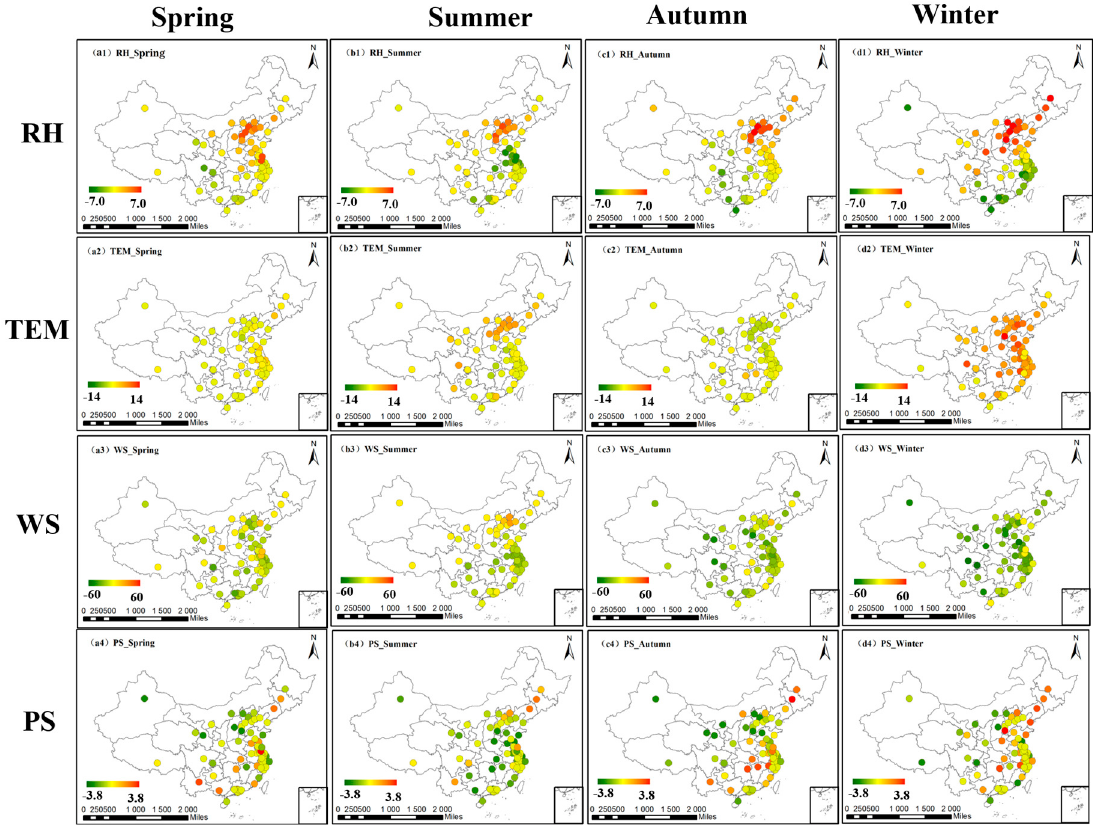
Figure 12. The distribution of the regression coefficient of four factors in four seasons.